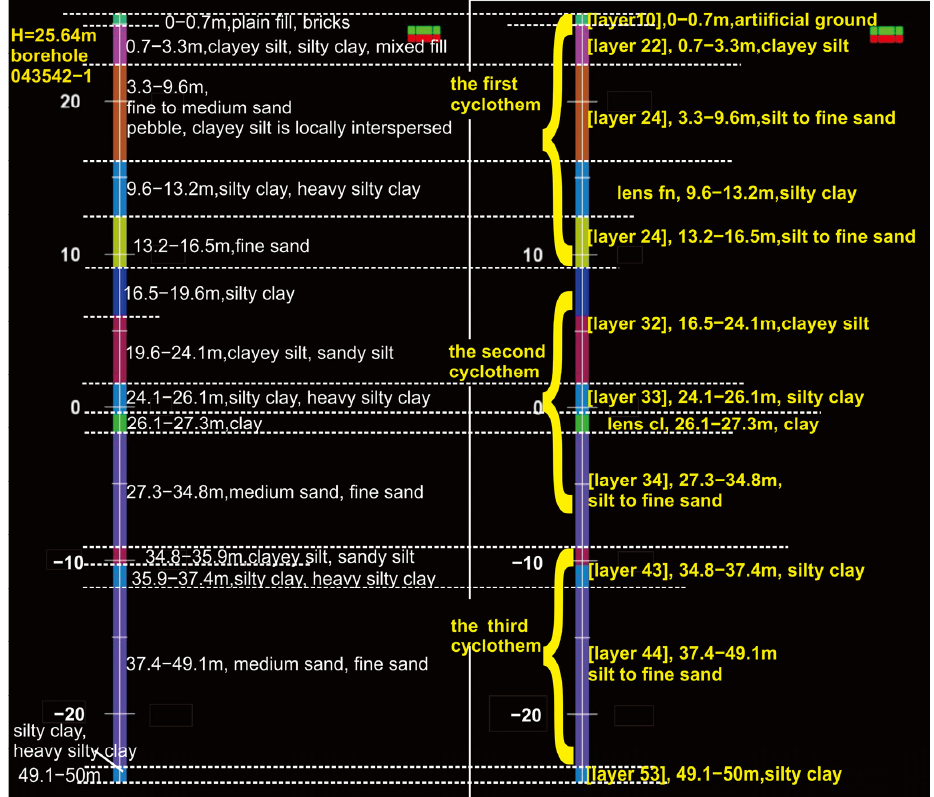
Figure 4. Lithology generalization; an example from borehole 043542-1.